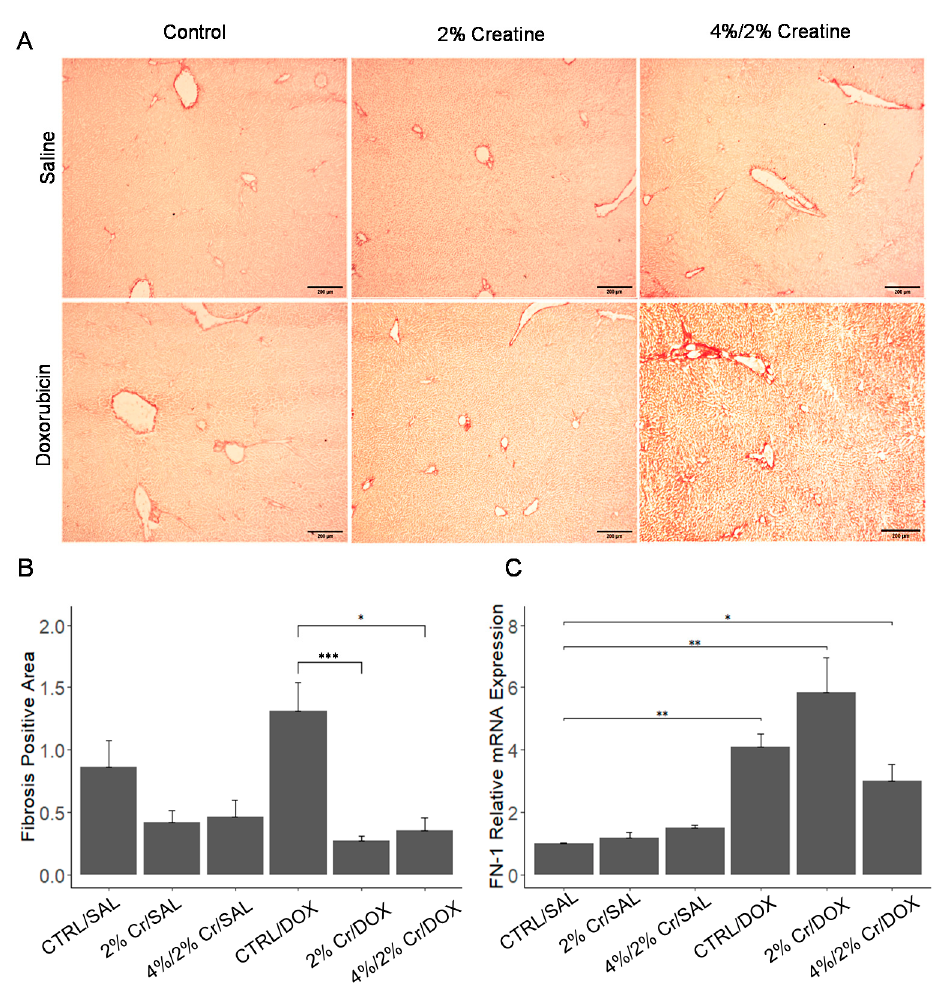
Figure 2. Liver fibrosis was measured by Picro-Sirius Red staining and mRNA expression of the fibrosis biomarker FN-1. Representative Sirius Red staining showing mild fibrosis in CTRL/SAL group ( A ). When images were quantified, a tendency of higher fibrosis was observed in CTRL/DOX when compared to the CTRL/SAL. Further, there was a significant decrease in 2% Cr/DOX and 4%/2% Cr/DOX when compared to CTRL/DOX ( B ). mRNA expression of FN-1 was elevated in CTRL/DOX and tend to reduce when DOX was combined with 4%/2% Cr ( C ). Three biological samples were imaged at 10× magnification and quantified using image J software. Four biological replicates are used, and mRNA expression is relative to β -Actin (ACTB). Data is reported as mean ± SE. * p < 0.05, ** p < 0.01, *** p < 0.001.